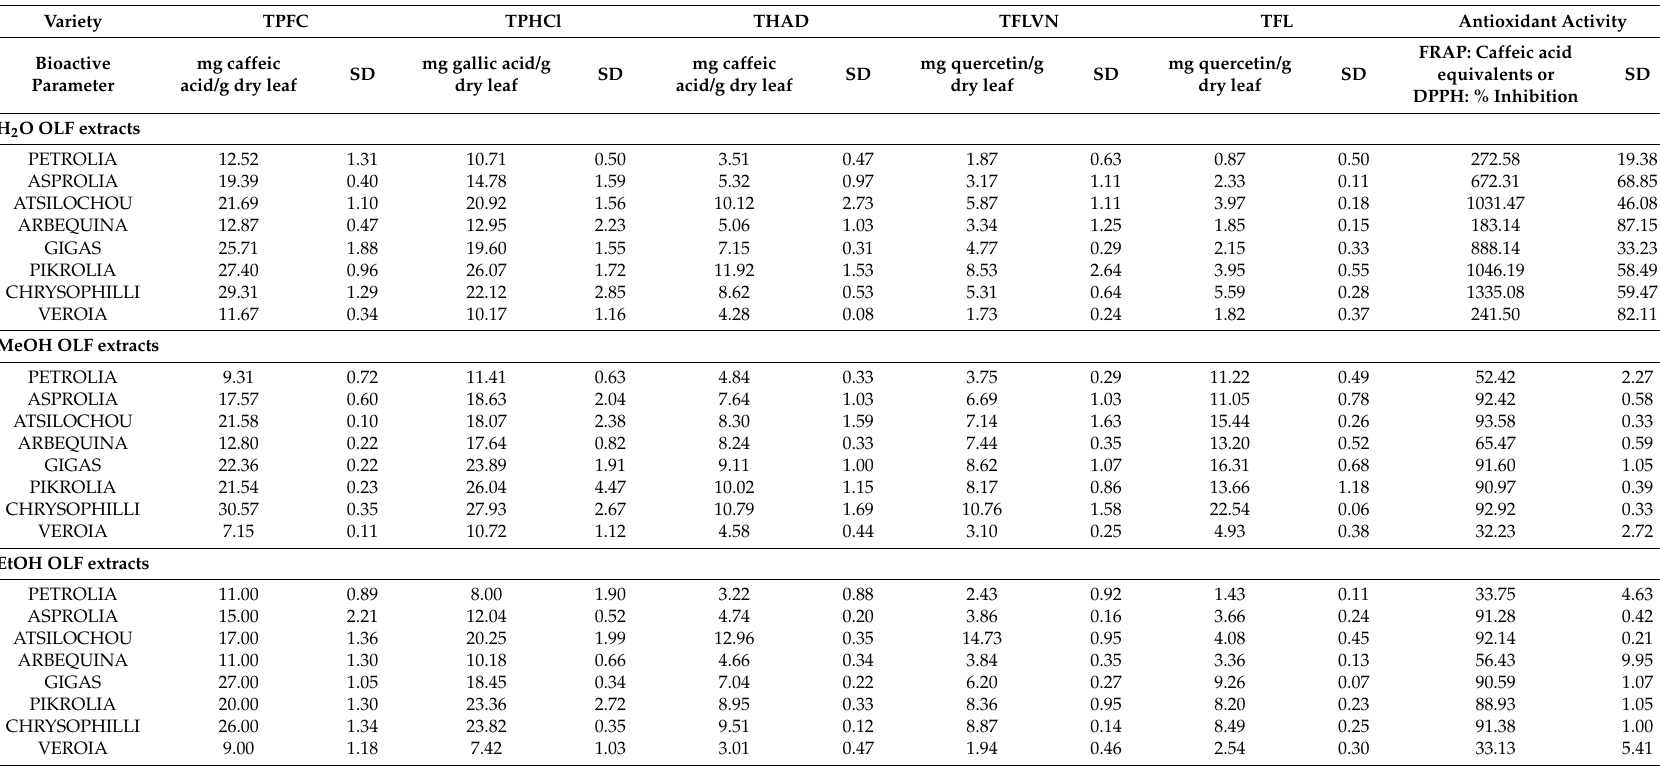
Table A1. Content of olive leaf (OLF) aqueous (H 2 O), methanol (MeOH), and ethanol (EtOH) extracts in Total Phenols (via the Folin–Ciocalteu assay: TPFC and via the Obied et al., assay: TPHCl), Total Hydroxycinnamic Acid Derivatives (THAD), Total Flavonols (TFLVN), Total Flavonoids (TFL), and antioxidant activity (caffeic acid equivalents of ferric reducing capacity (FRAP) for the aqueous and % DPPH radical scavenging inhibition for the alcoholic extracts).